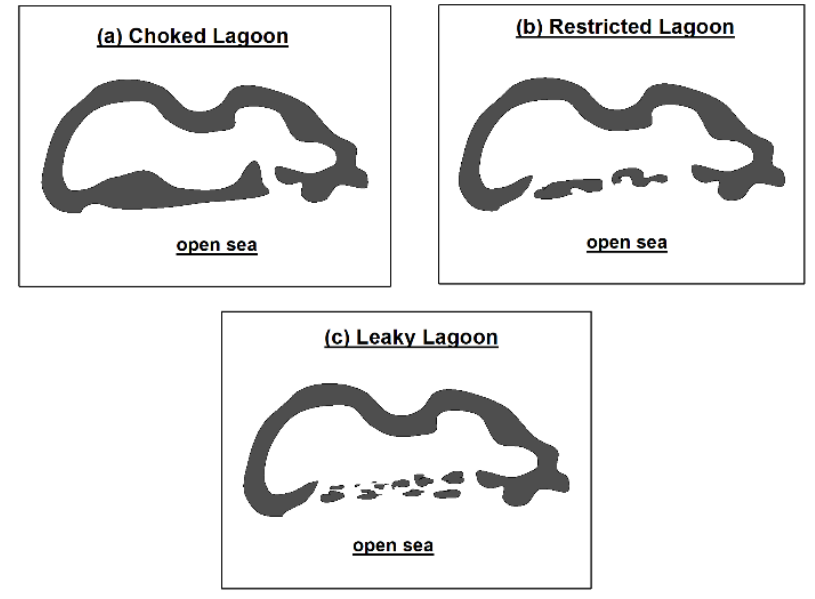
Figure 1. Coastal lagoons sub-divided into ( a ) choked, ( b ) restricted and ( c ) leaky (remodified after [3]).